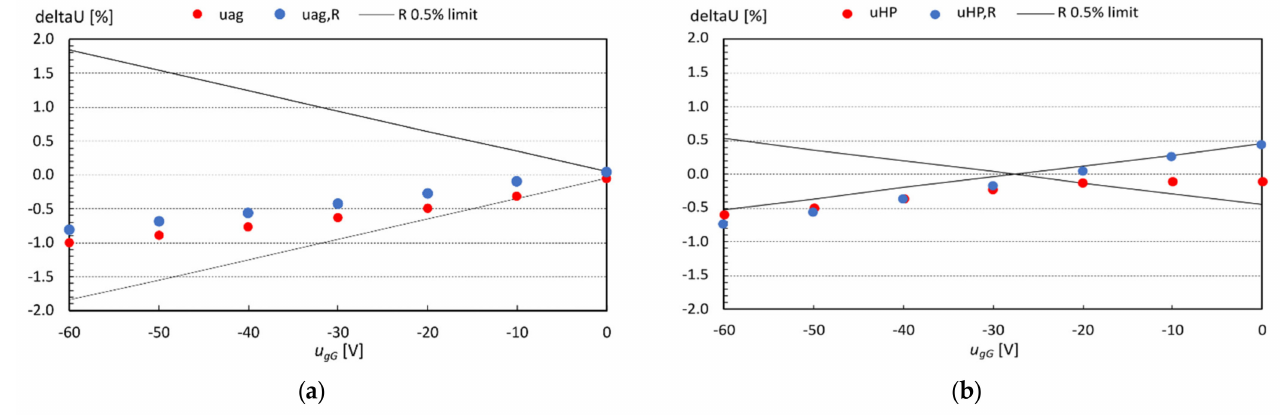
Figure 17. Voltage error vs. u gG for original and reversed polarity of measured voltage: ( a ) for u ag = 3.3 V; ( b ) for u HP = 60 V.